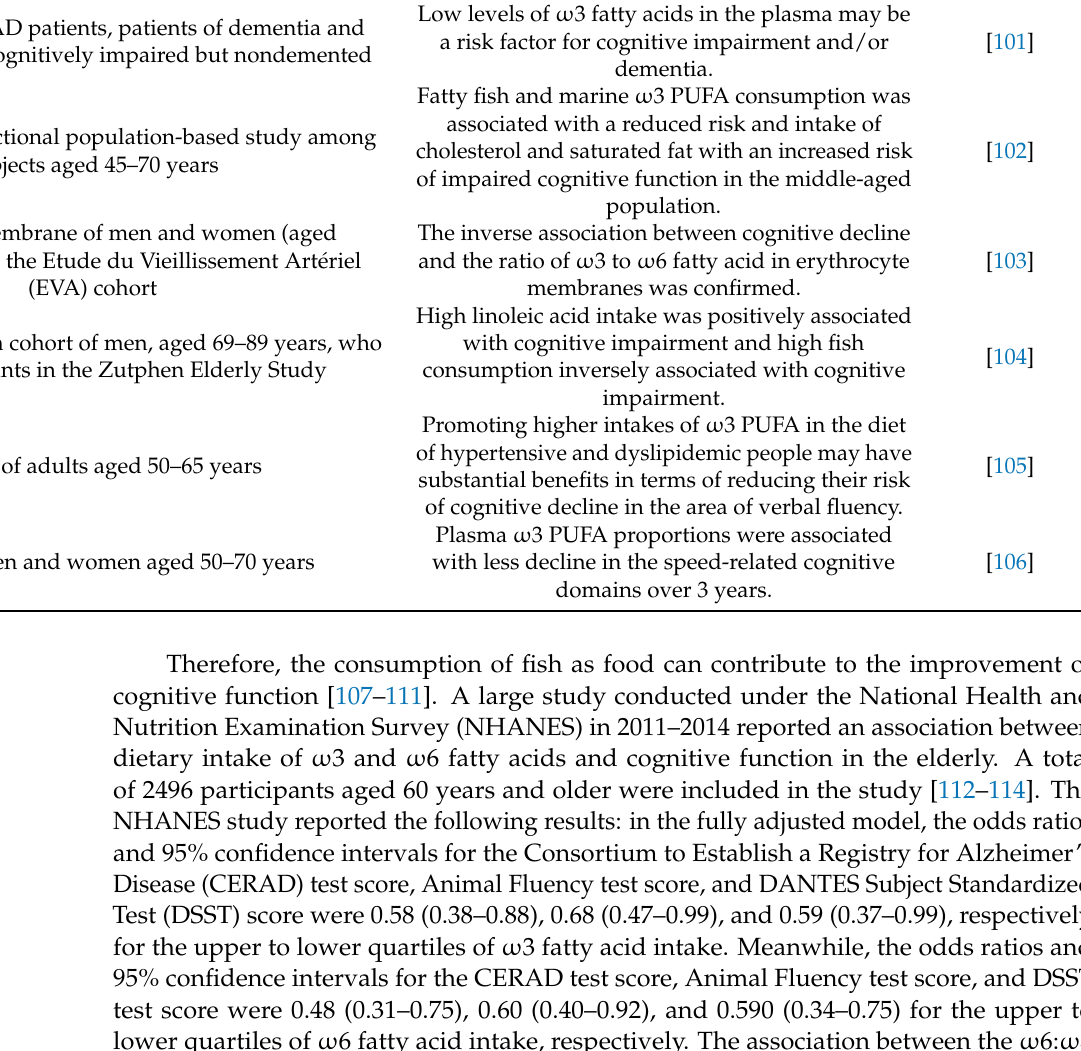
Table 3. Previous study on the relationship between ω 3 fatty acids and cognitive function. Study